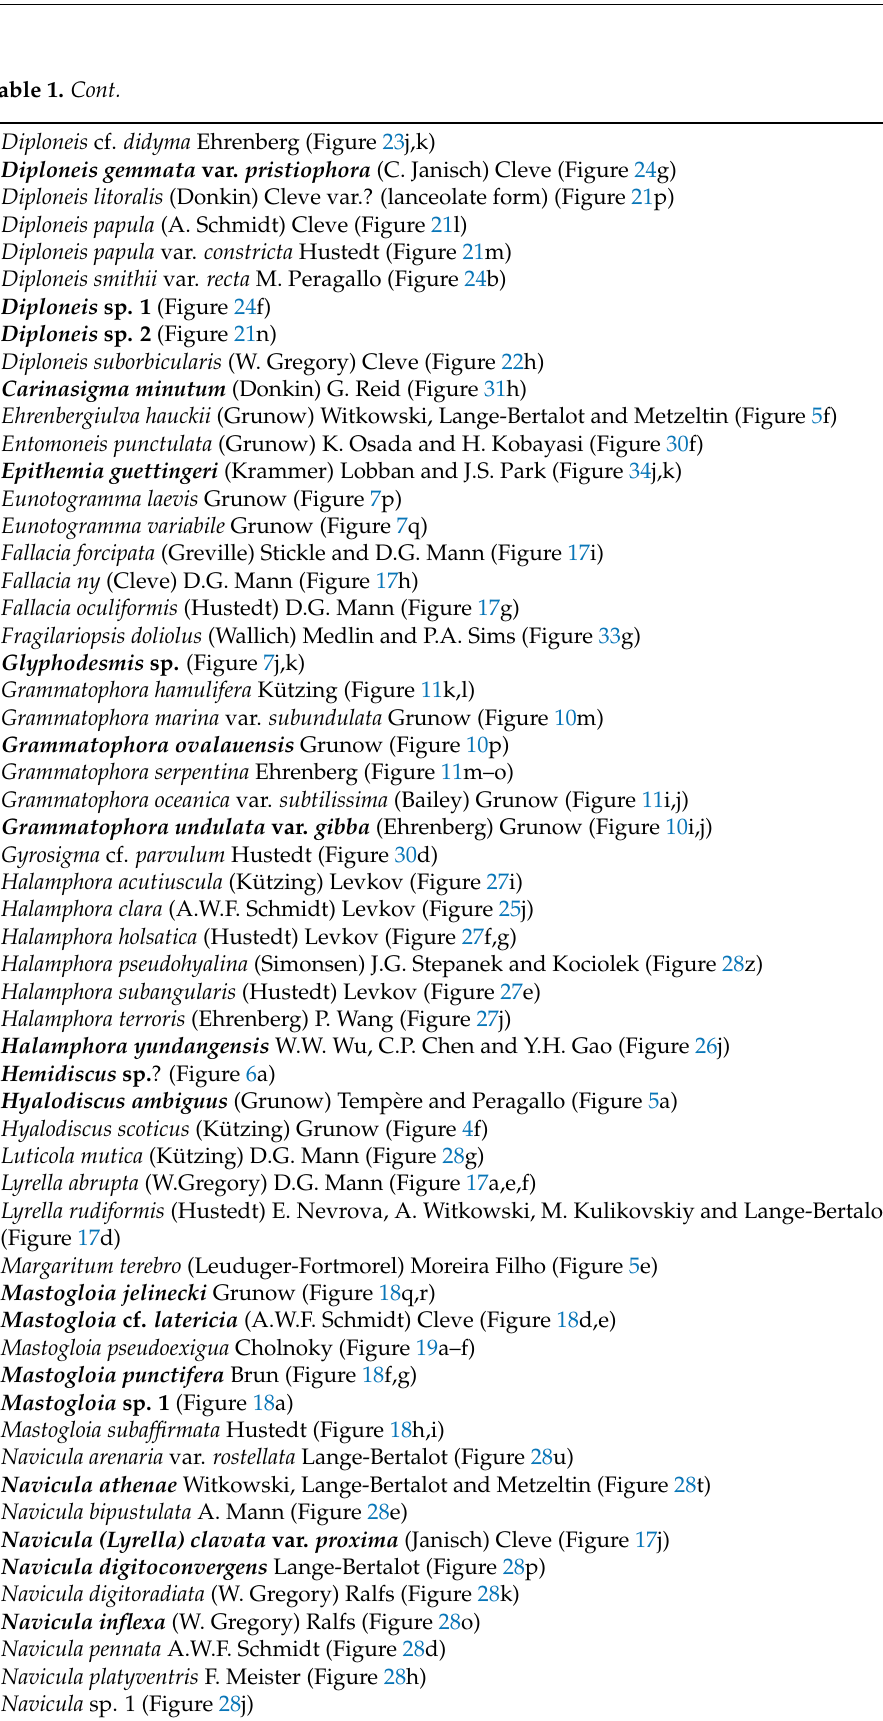
Mastogloia sp. 1 (Figure